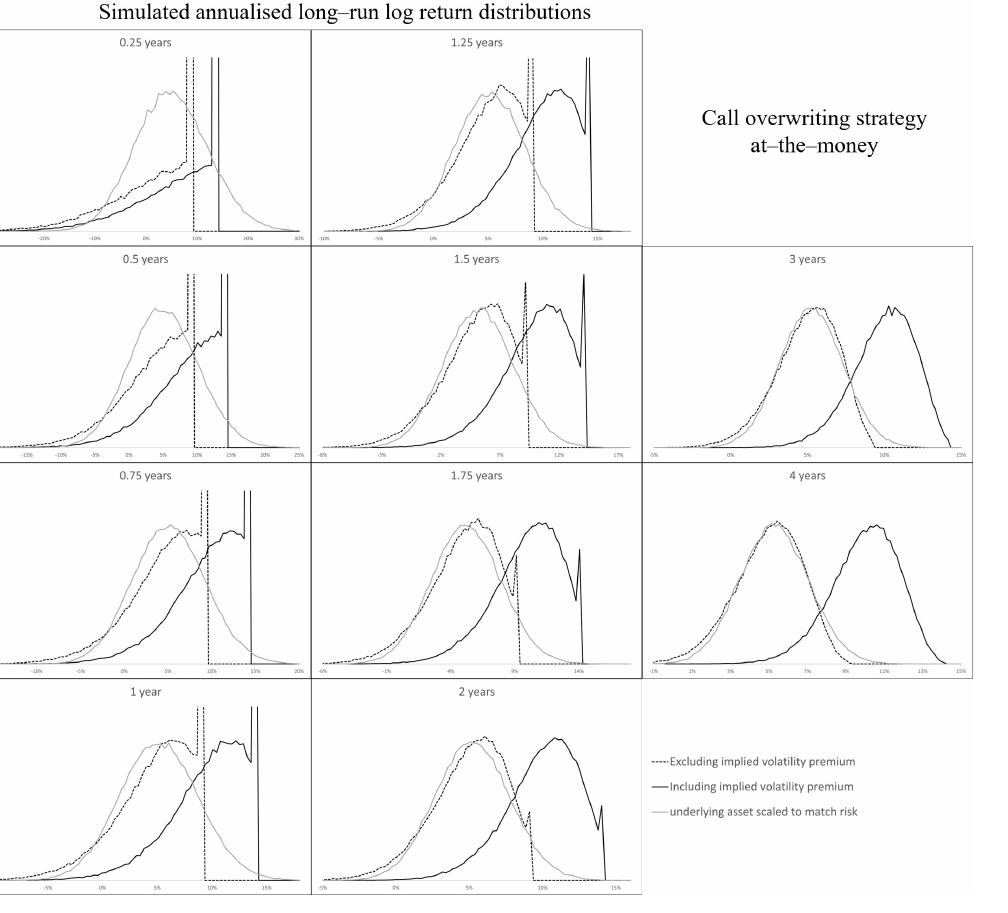
Figure 19. Simulations of the long-run returns of an underlying asset overlaid with a quarterly at-the-money call overwriting strategy over investment horizons of 1 / 4 year, 1 / 2 year, 3 / 4 year, 1 year, 1 1 / 4 years, 1 1 / 2 years, 1 3 / 4 years, 2 years, 3 years, and 4 years. The dotted line assumes the implied volatility is equal to the underlying asset volatility. The solid line includes the implied volatility premium in the price of the options. The gray line shows the long-run returns of a portfolio consisting of the risk-free asset and the underlying asset weighted to have the same risk as the option